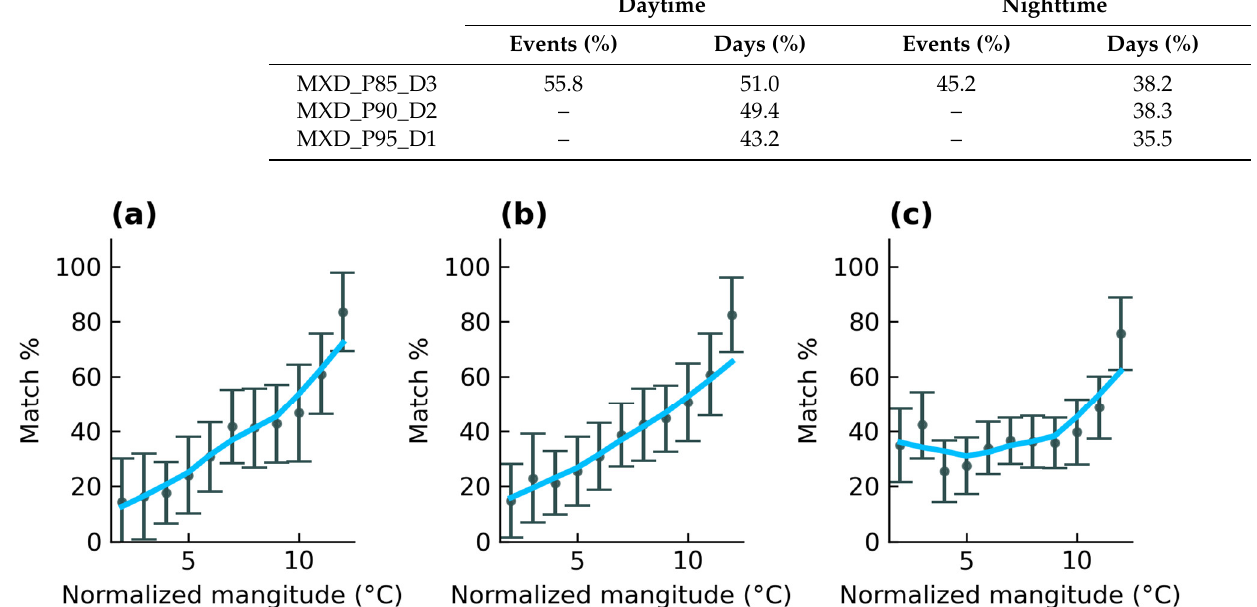
Figure 4. Match percentage between heatwave days and LST anomalies as a function of the normalized heatwave magnitude during daytime for ( a ) MXD_P85_D3, ( b ) MXD_P90_D2, and ( c ) MXD_P95_D1; blue curves correspond to the lowess regression lines; error bars correspond to half standard deviation.